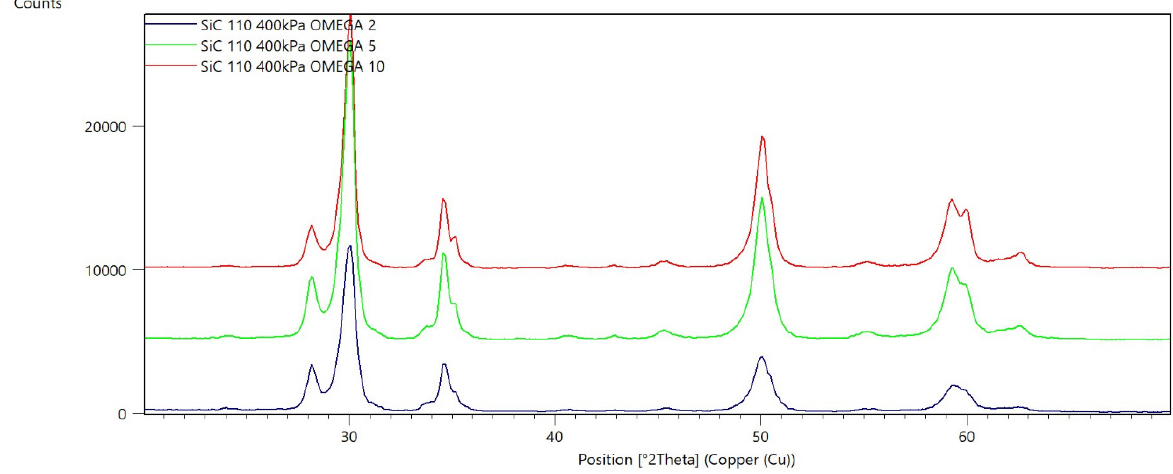
Figure 12. Diffraction patterns of sample K (abrasive—SiC 250 μ m, pressure 200 kPa). Figure 13. Diffraction patterns of sample L (abrasive—SiC 250 μ m, pressure 400 kPa). The presented diffraction patterns show that for each type of treatment, a monoclin- ic phase appears—a characteristic peak at the 2Theta angle = 28.1°. Depending on the